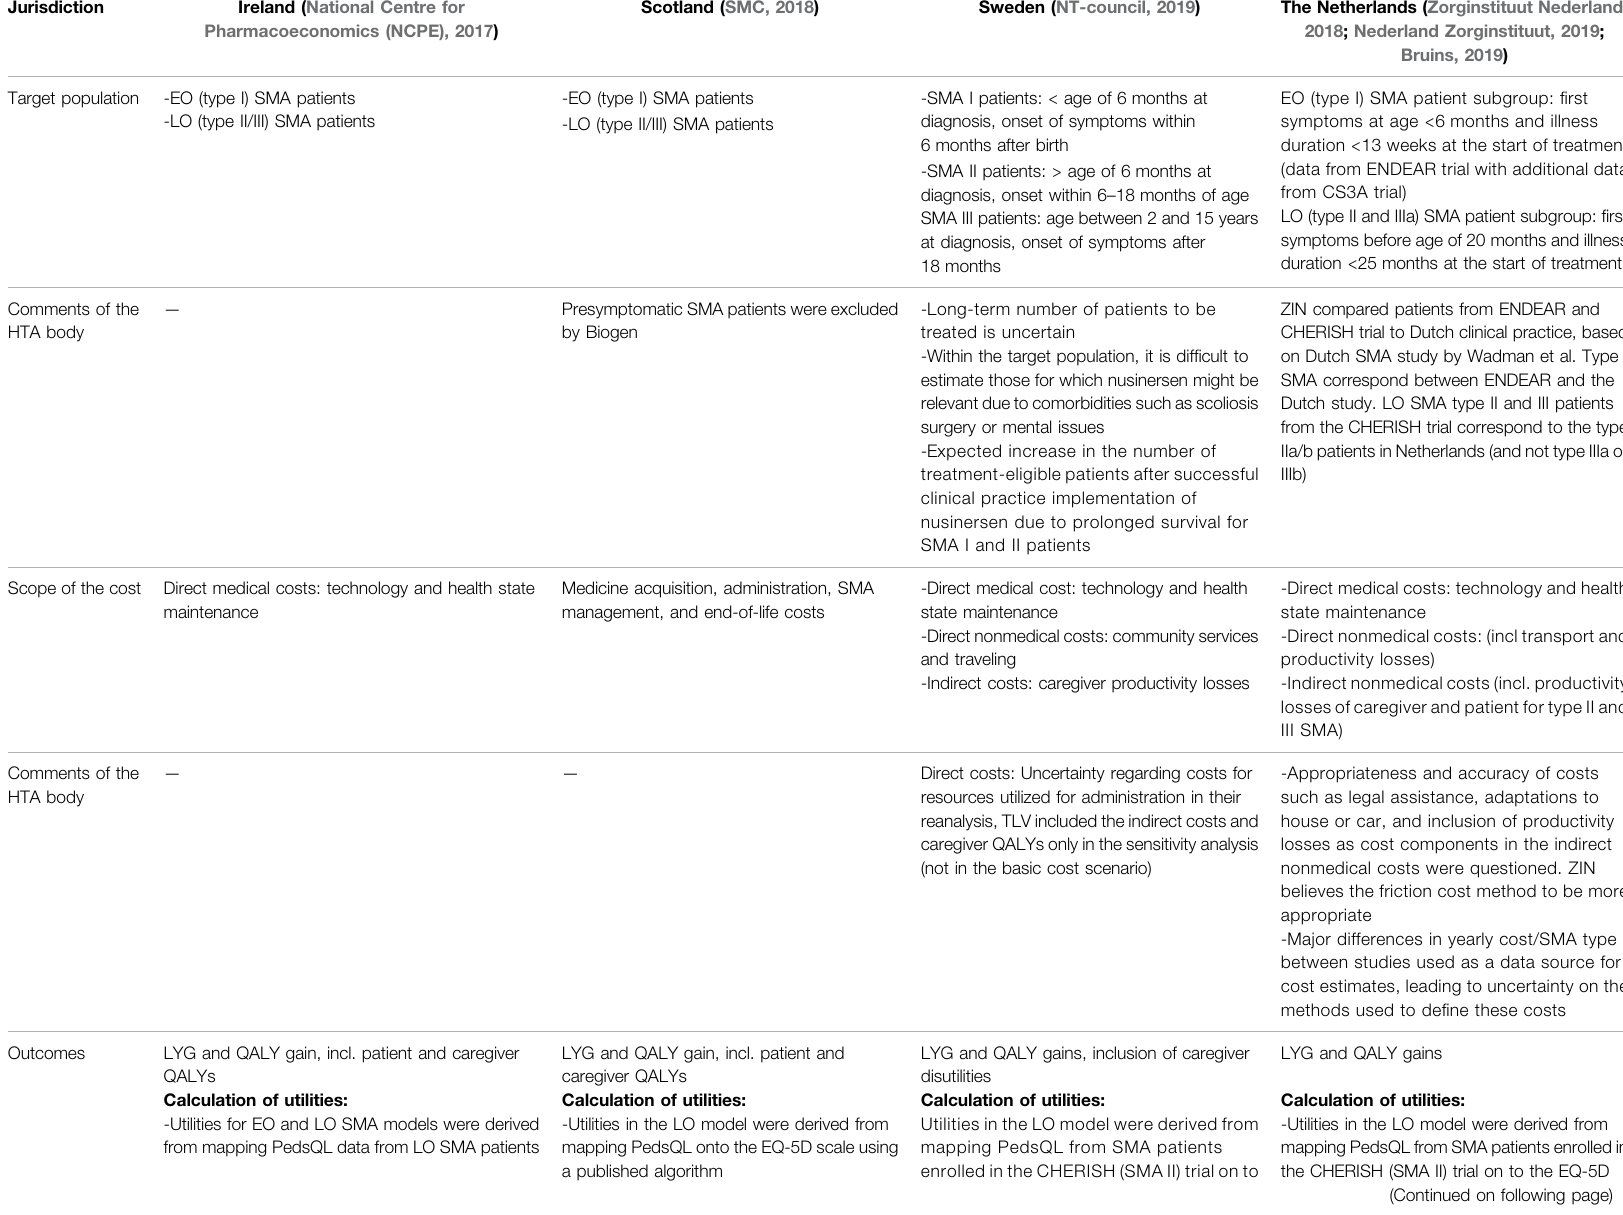
TABLE 2 | ( Continued ) Overview of the design of the economic evaluation of nusinersen in six European countries, the US, and